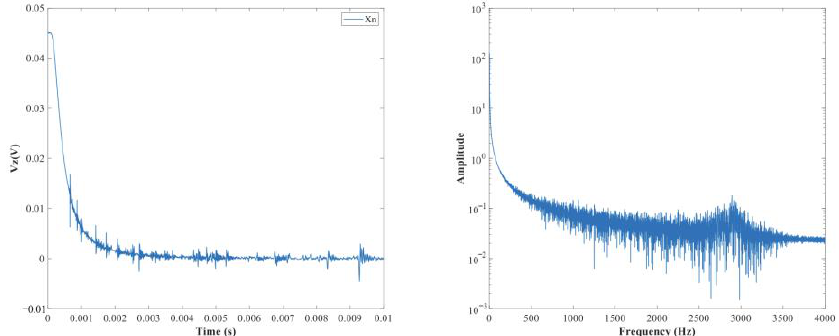
Figure 6. GREATEM signal with measured noise and corresponding frequency spectrum.